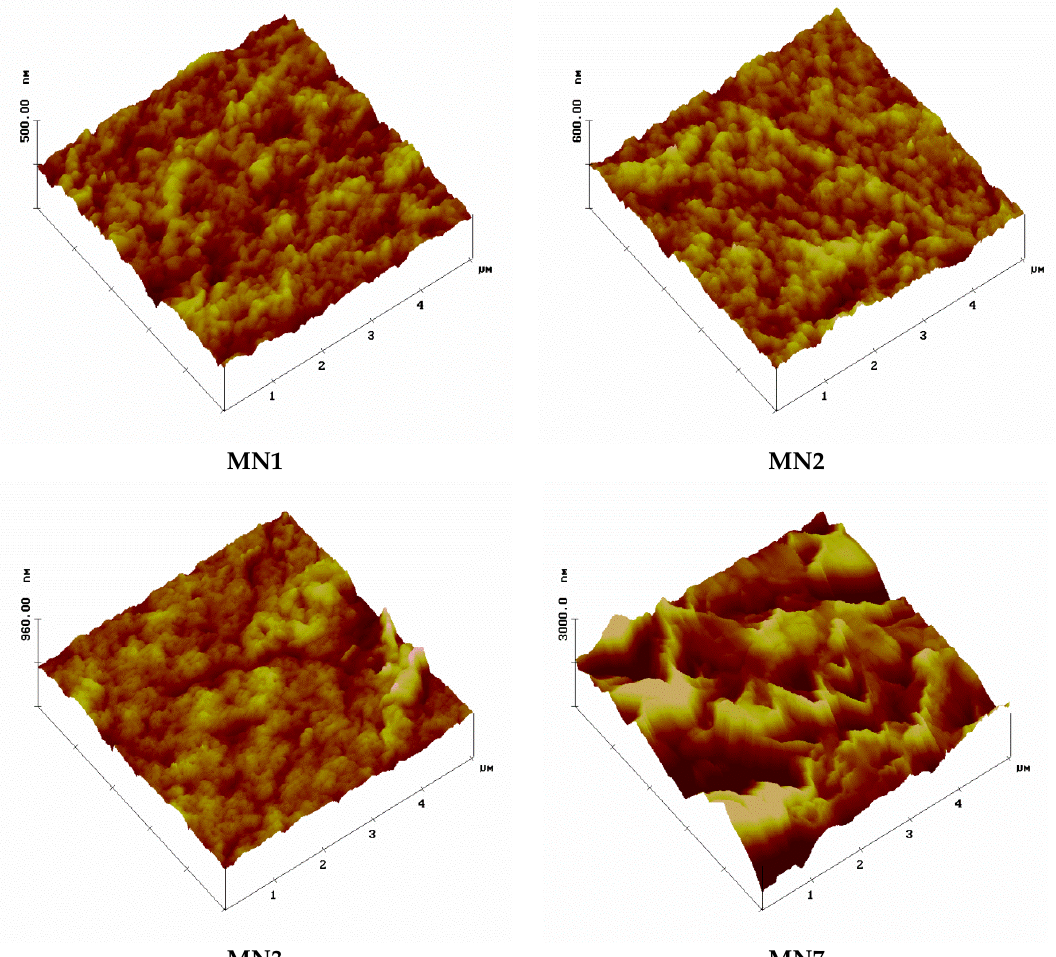
Figure 7. AFM three-dimensional surface structure (roughness) of the prepared PVDF membranes (MN1, MN2, MN3 and MN7).